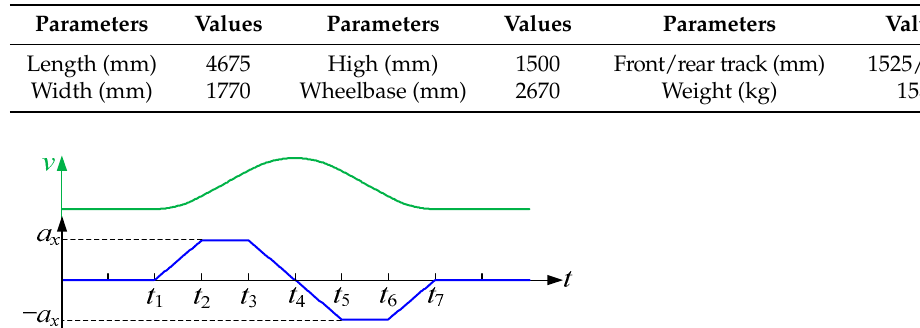
Figure 10. The curves of translation acceleration a x and translational speed v.